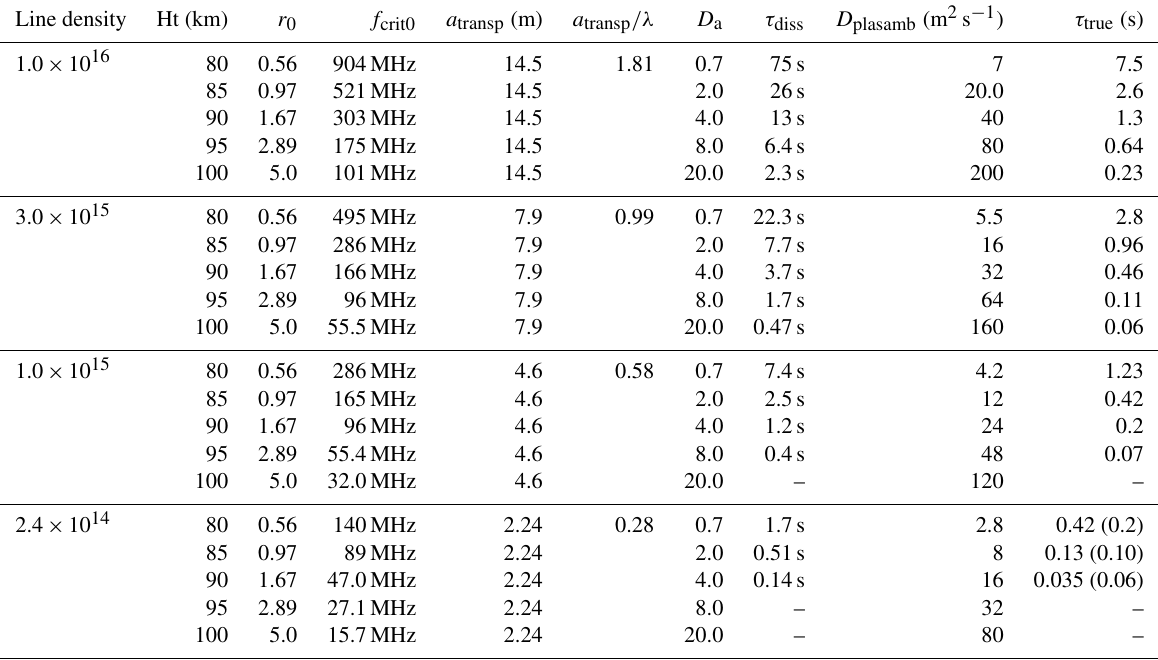
Table C1. Various spatial and temporal scales associated with the diffusive expansion of a meteor trail. f crit0 : critical reflection frequency at time of trail formation (higher frequencies will penetrate trail). a transp : value of “ a ” at which trail becomes transparent at a radio frequency of 35MHz ( λ = 8m). D a : ambient diffusion coefficient. τ diss : time to reach “ a transp ” and thus disappear, based on D a . D plasamb : geometric mean diffusion coefficient, allowing for temporal variation of plasma temperature with time. τ true : time to reach “ a transp ” using D plasamb . The last group shows the case of line density of 2.4 × 10 14 electronsm − 1 , generally regarded as a cut-off density beyond which the trails can no longer be considered as underdense. Bracketed quantities in the last column for the transitional frequency refer to a knee in the CCD of the Socorro radar; these are further discussed in the main